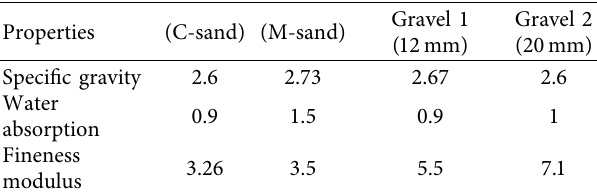
Table 7: Properties of aggregates.